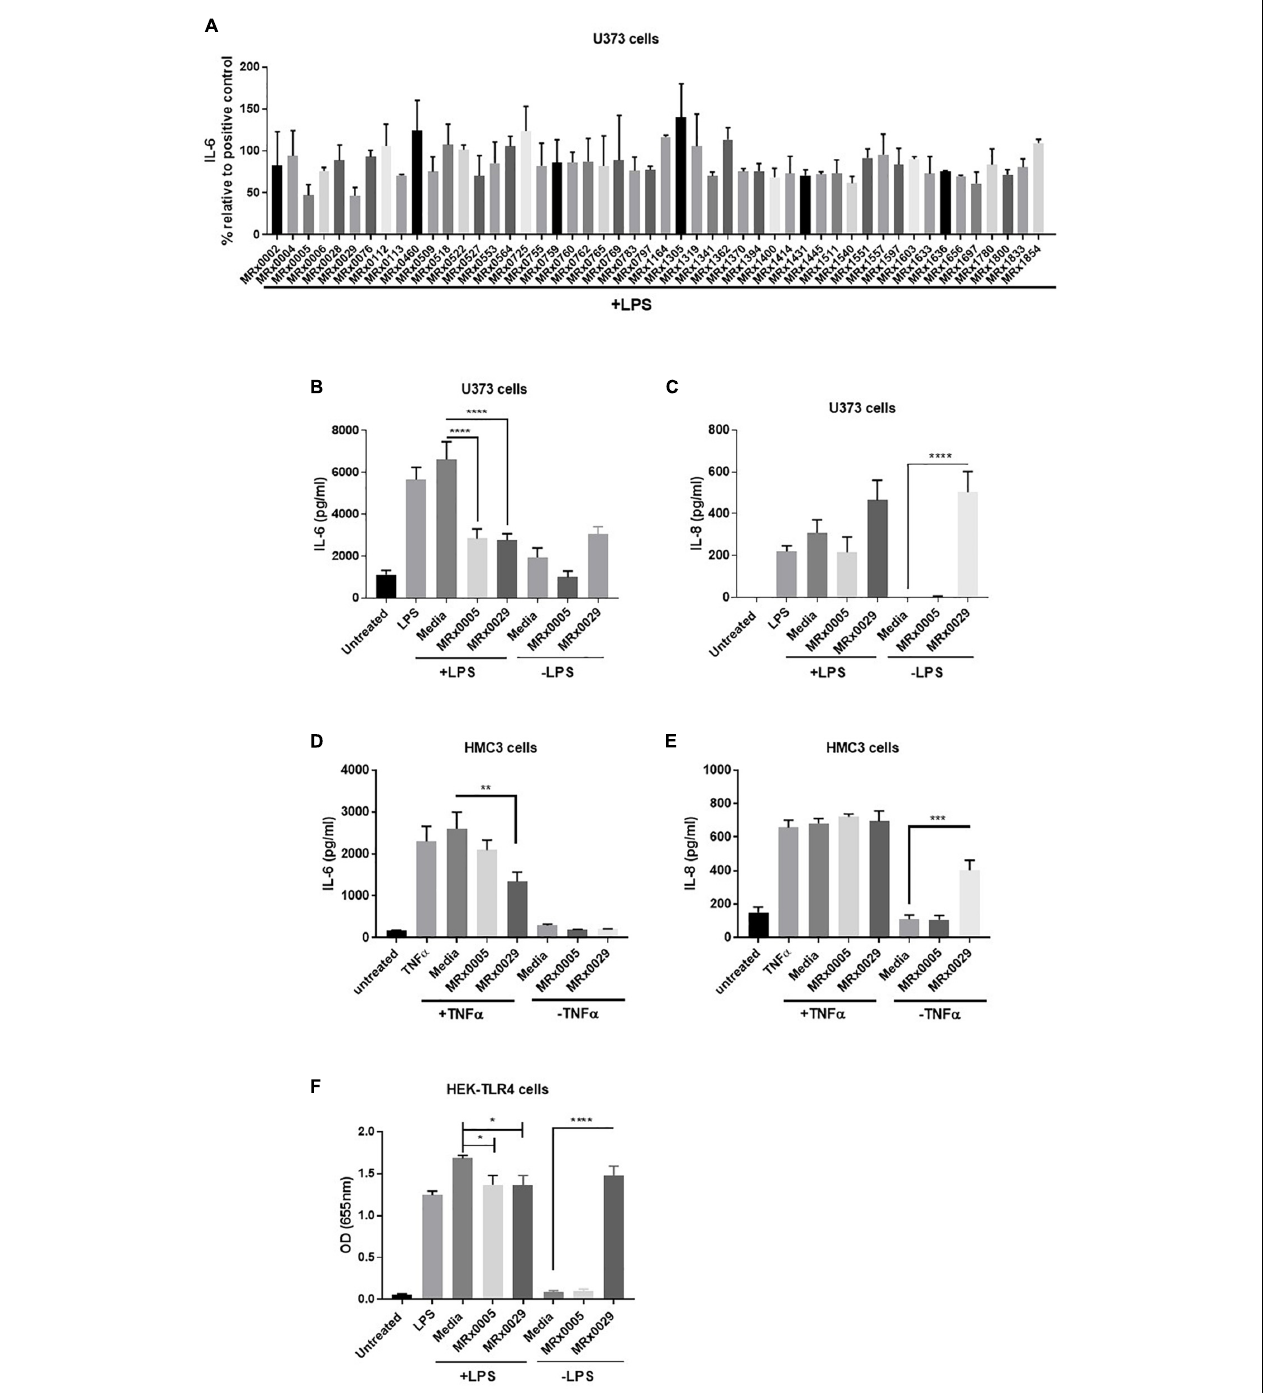
FIGURE 1 | Differential mode of action between MRx0005 and MRx0029: implication for neuroinflammation. U373 cells were pre-treated with 1 µ g/ml LPS followed by 10% bacterial cell-free supernatants (BCFS) or media alone. Cell-free supernatants were collected 24 h after treatment from U373 cells and secretion of IL-6 was measured by ELISA. Data are mean ± SEM ( n = 2) (A) . U373 cells were treated with 1 µ g/ml LPS followed by 10% BCFS from MRx0005 and MRx0029 and secretion of IL-6 (B) and IL-8 (C) measured by ELISA. Controls included also cells treated with BCFS alone. Data are mean ± SEM ( n = 5 for IL-6, n = 4 for IL-8). HMC3 cells were pre-treated with TNF- α and then with 10% BCFS from MRx0005 and MRx0029 or media alone for 24 h and IL-6 (D) and IL-8 (E) measured by ELISA. Controls included also cells treated with BCFS alone. Data are mean ± SEM ( n = 3). (F) HEK-Blue hTLR4 cells were treated with 10 ng/ml LPS in the presence of 10% BCFS from MRx0005 and MRx0029 or media as control. Controls included also cells treated with BCFS alone. After 22 h, NF- κ B-induced SEAP activity was measured using QUANTI-Blue at 655 nm. Data are mean ± SEM ( n = 5).